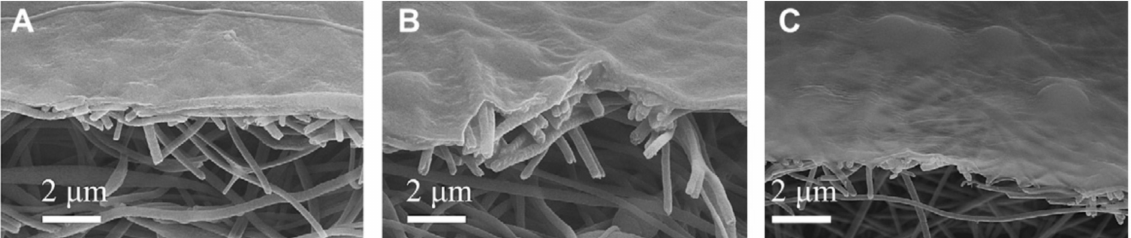
Figure 4. Cross-section SEM images thin film composite membranes of cellulose ( A ), chitin ( B ), and cellulose-chitin blend ( C ) barrier layers prepared by ionic liquid regeneration. Provided with permission from Elsevier